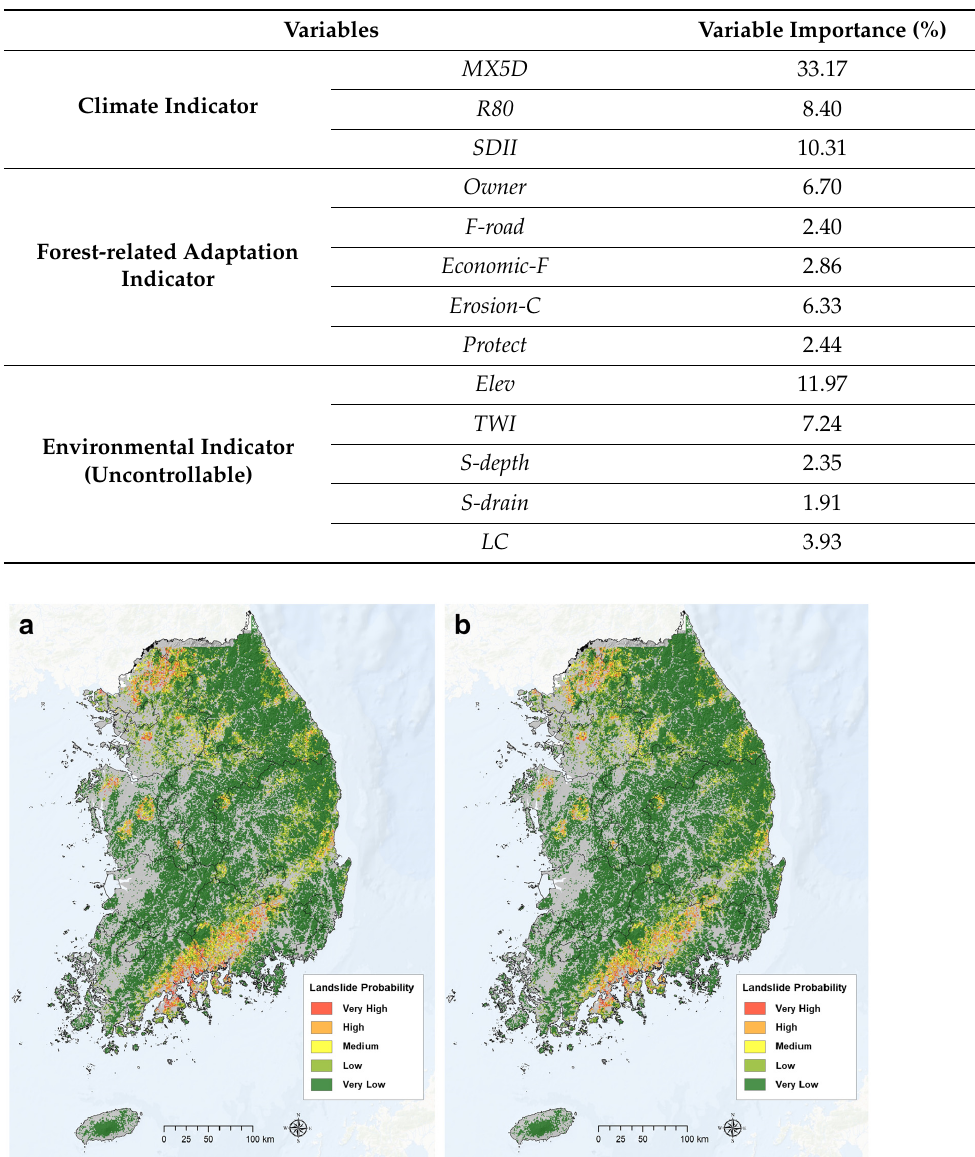
Table 3. Importance of variables used in baseline prediction.